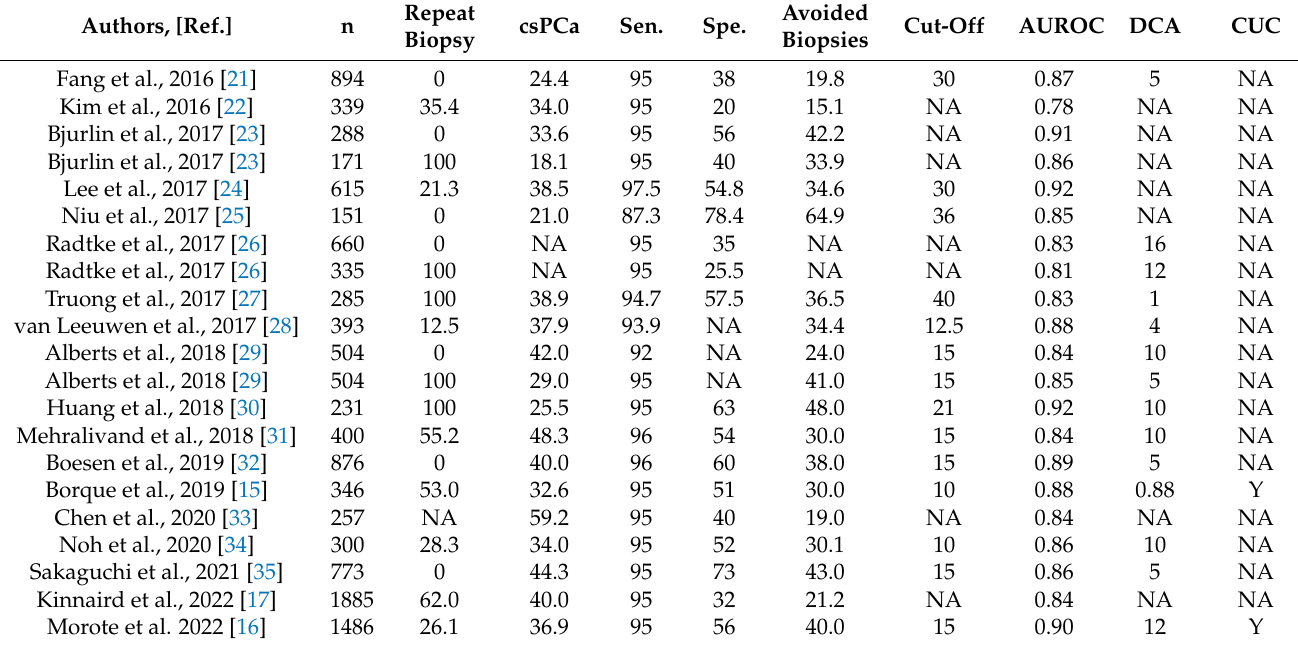
Table 3. Clinical usefulness of developed